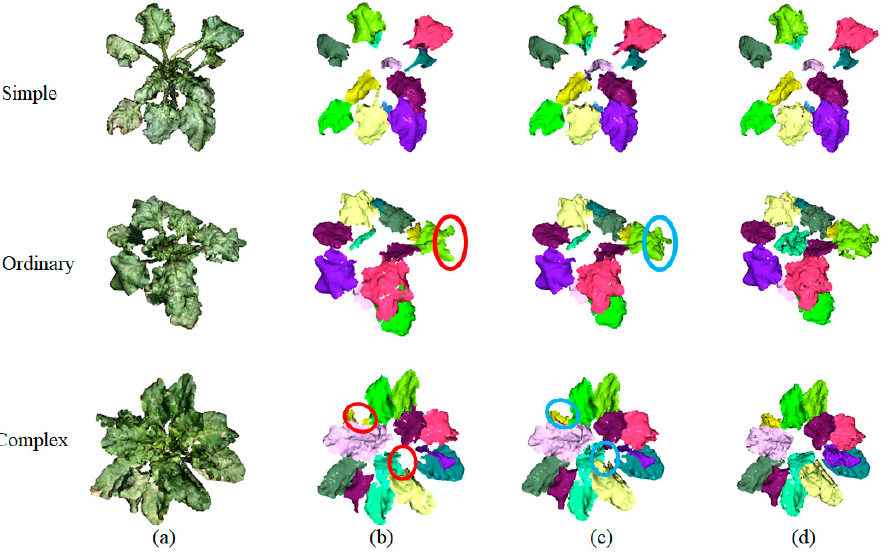
Figure 9. Visualization of the leaf segmentation results using the combinations of different methods. The first row, the second row and the third row are one of the simple, ordinary and complex plant type structures; ( a ) are the individual sugar beet plants to be proceeded. ( b ) are the results of leaf segmentation by using the region-growing algorithm combined with SBF. The red circles are the regions segmented incompletely. ( c ) are the results of leaf segmentation by using the MSTVM-based region-growing algorithm combined with SBF. The blue circles are the regions segmented correctly. ( d ) are the manual segmentation results (ground truth). Table 5. The Mean and standard deviation of segmented leaves for the whole plant by the MSTVM- based region-growing algorithm combined with the SBF and by the region-growing algorithm combined with SBF.